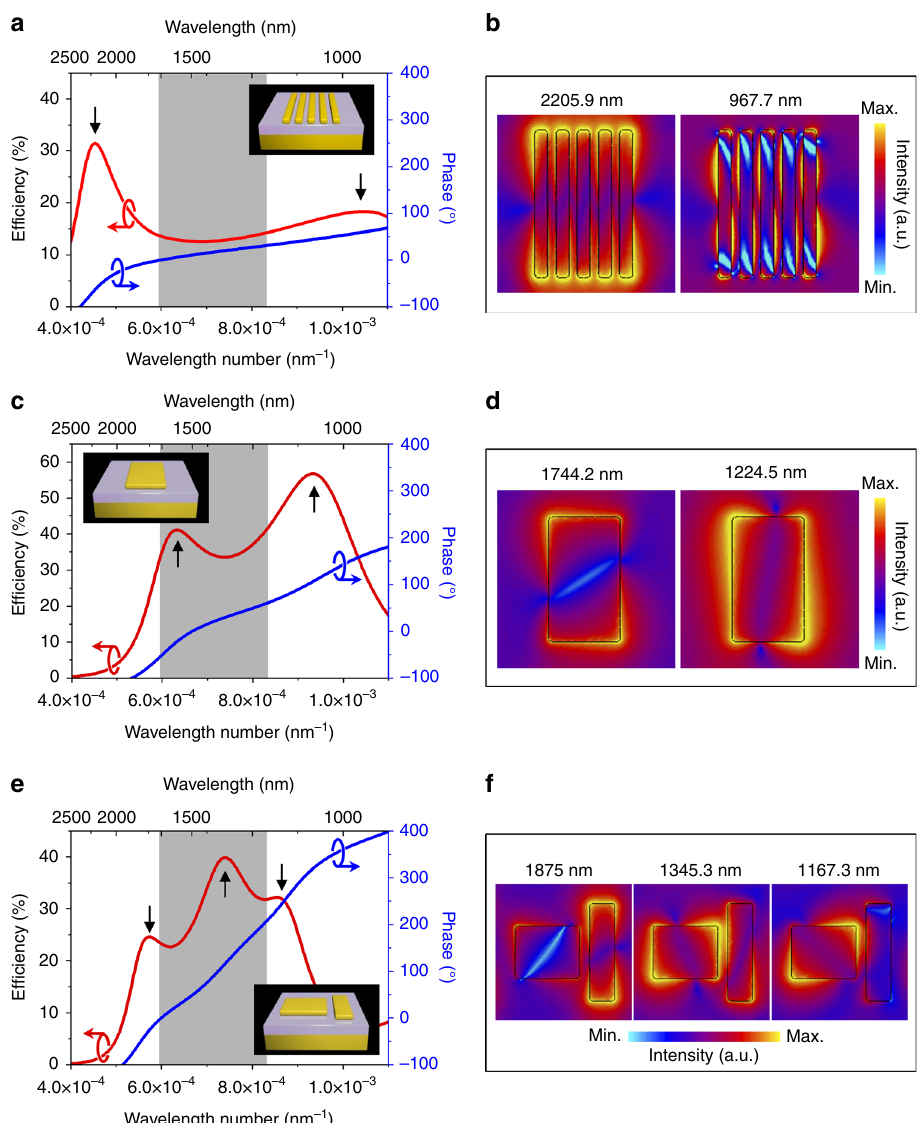
Fig. 2 Phase pro fi le of integrated-resonant unit elements based on coupled nano-rods. a , c , e RCP-to-LCP polarization conversion ef fi ciency ( red curves ), phase pro fi le ( blue curves ) and ( b , d , f ) electric fi eld distribution (color mapping) of integrated-resonant unit elements. Each unit element with 550 nm periods along x and y axes consists of one or several gold MNRs with fi xed thickness 30 nm. The MNRs stand on a SiO 2 /Au substrate with varying gap size, length and width are optimized to achieve various phase compensation between λ min and λ max (Supplementary Tables 1 and 2). The thickness of dielectric spacer SiO 2 is 60 nm. Gray region and black arrows remark the range of working bandwidth of BAML and positions of resonant modes,